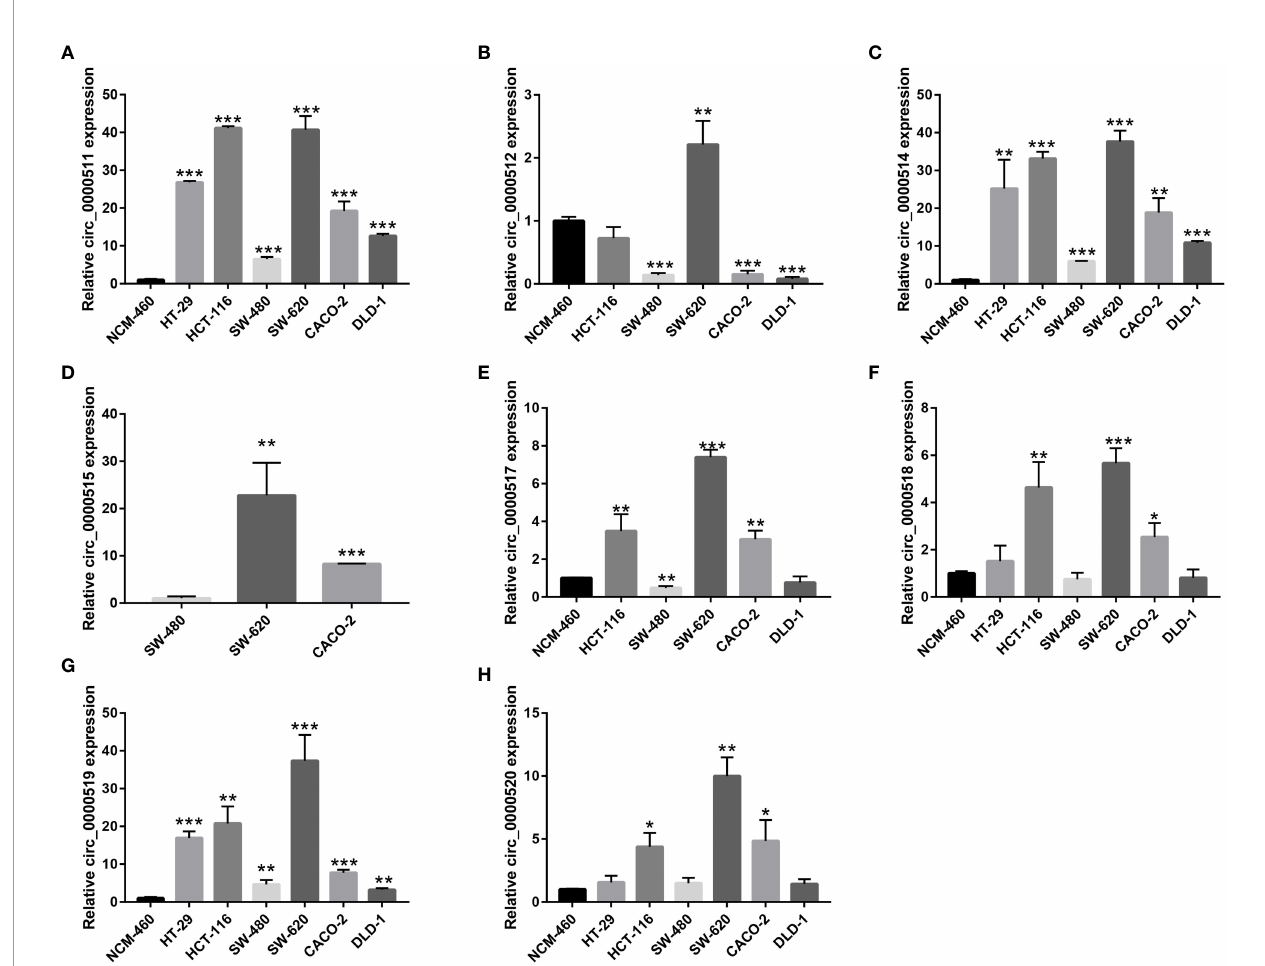
FIGURE 12 | Relative circular RNA (circRNA) expression in colorectal cancer (CRC) cells and NCM-460 normal cells by qRT-PCR. (A) For hsa_circ_0000511, (B) for hsa_circ_0000512, (C) for hsa_circ_0000514, (D) for hsa_circ_0000515, (E) for hsa_circ_0000517, (F) for hsa_circ_0000518, (G) for hsa_circ_0000519, and (H) for hsa_circ_0000520. (***p ≤ 0.001, **p ≤ 0.01, *p ≤